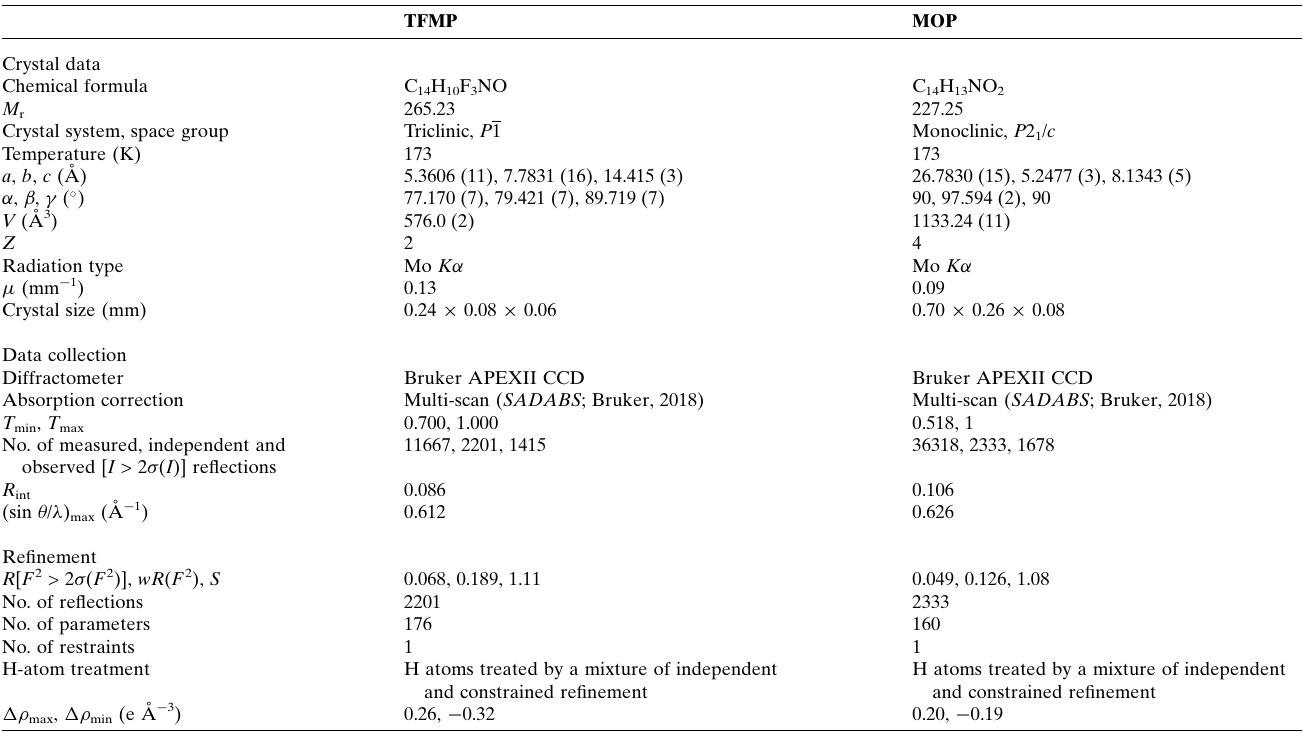
Table 4 Experimental details.